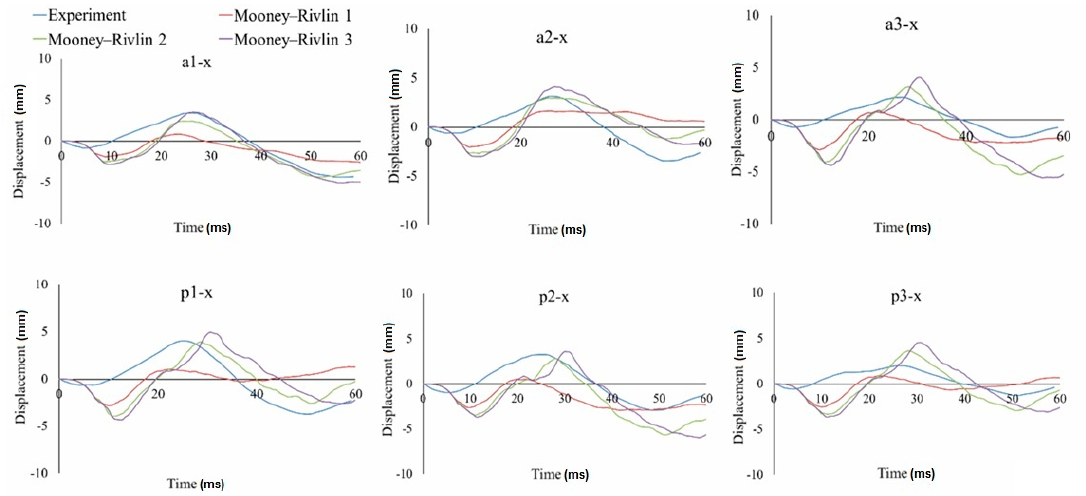
Figure 4. Displacement-in-time characteristics of the markers in the frontal (a) and rear columns (p) in the X-direction using the hyperelastic material models based on the Mooney-Rivlin constitutive equations.